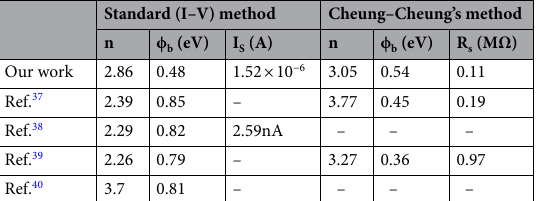
Table 6. The I–V parameters of n-Si/p-NiO heterojunction structure and the related literature data. n ideality factor, ϕ b barrier height value, I S saturation current, R s series